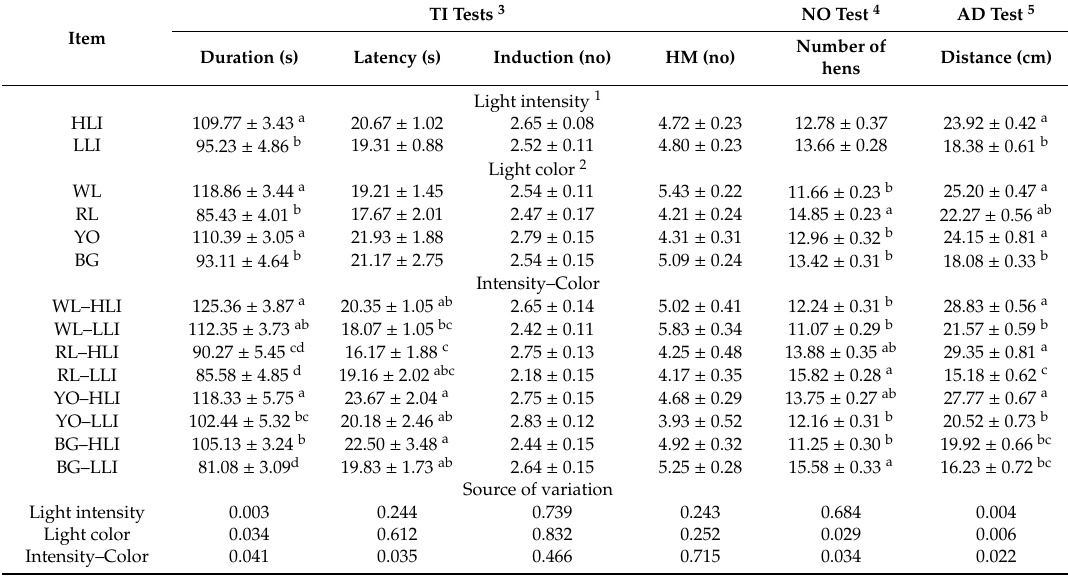
Table 4. Means ( ± SE) of responses of hens to the TI test, NO test, and AD test in response to light colors and light intensities